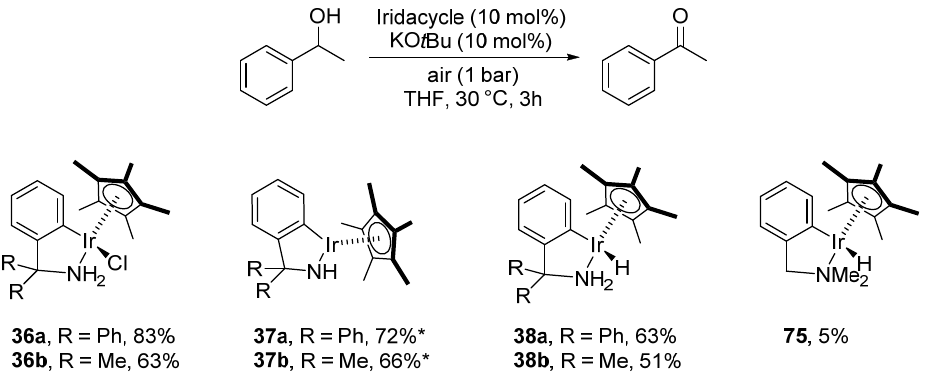
Table 2. Aerobic oxidative kinetic resolution of secondary